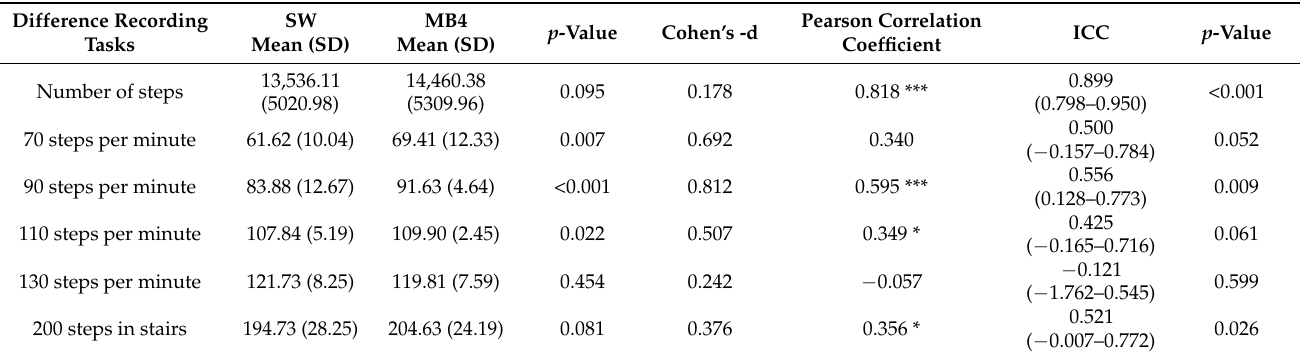
Table 1. Validation statistics of the steps recorded by comparing the SW monitors and the Xiaomi MB4 wristband.